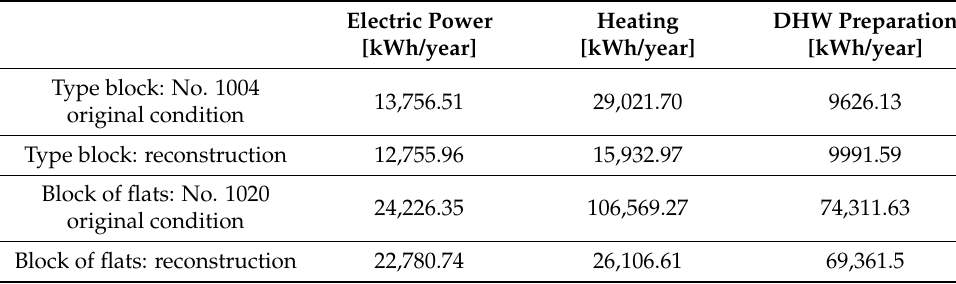
Table 4. The values of the total consumption of each type of building in a given urban